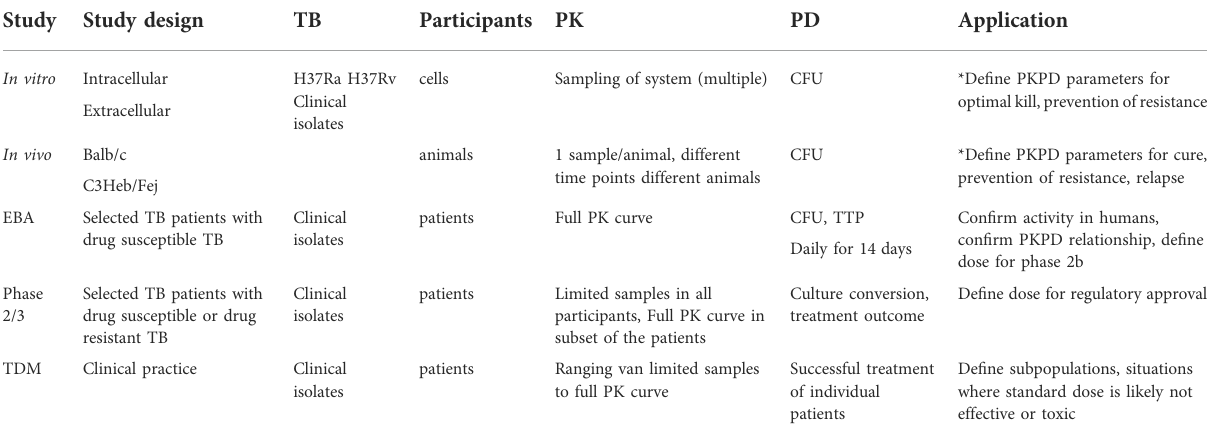
TABLE 2 Key aspects of PKPD studies.